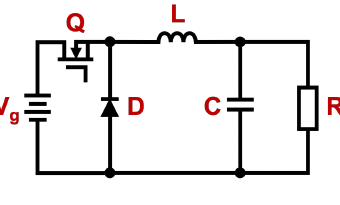
Figure 2. Buck converter